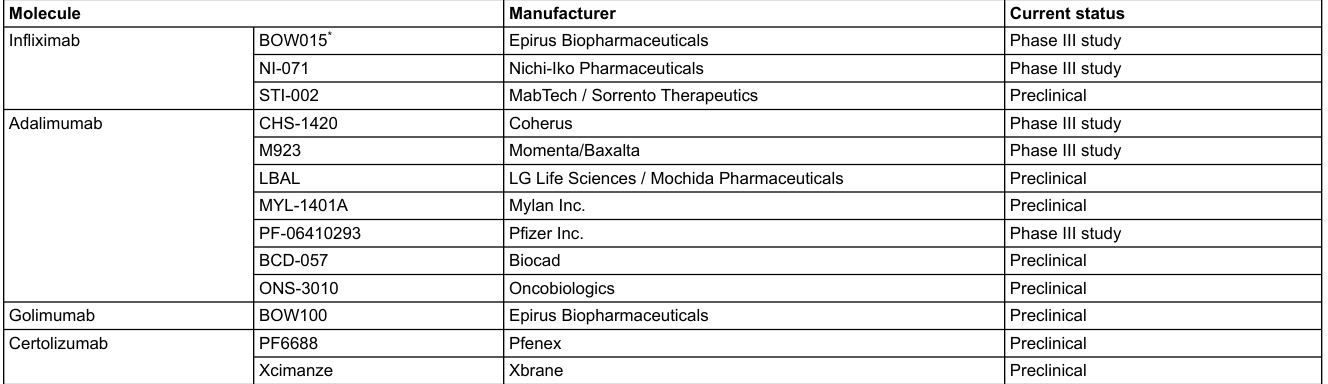
Table 2: Biosimilars under development for possible use in inflammatory bowel disease.